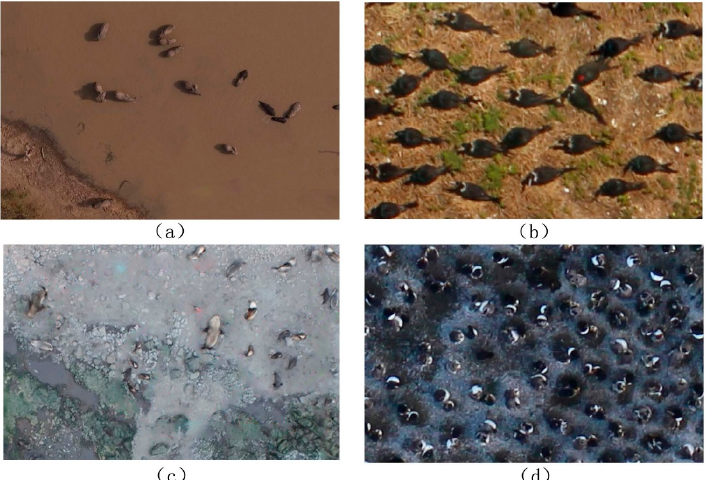
Figure 3. UAS imagery of wild animals: ( a ) Elephants in the Nazinga Game Ranch in the south of Burkina Faso [43], ( b ) breeding lesser frigatebirds ( Fregata ariel) in the tropical Ashmore Reef Commonwealth Marine Reserve and on the nearby Adele Island, Western Australia [54], ( c ) fur seals [57], and ( d ) molting royal penguins ( Eudyptes schlegeli) on the subantarctic Macquarie Island, Australia [54]. These studies demonstrate that using UAS technology can significantly improve the e ffi ciency and precision of surveying hard-to-reach wild animal populations and places compared with using traditional ground-based